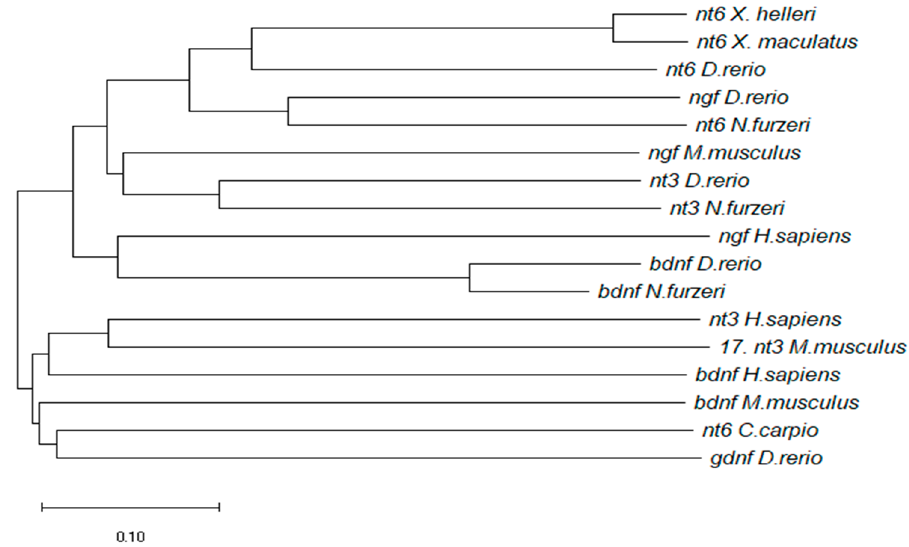
Figure 1. Evolutionary relationships of taxa. The evolutionary history was inferred using the Minimum Evolution method. The optimal tree with the sum of branch length = 4.92138622 is shown. The tree is drawn to scale, with branch lengths in the same units as those of the evolutionary distances used to infer the phylogenetic tree. This analysis involved 17 nucleotide sequences. Codon positions included were 1st + 2nd + 3rd + Noncoding. All ambiguous positions were removed for each sequence pair (pairwise deletion option). There were 3752 positions in the final dataset.